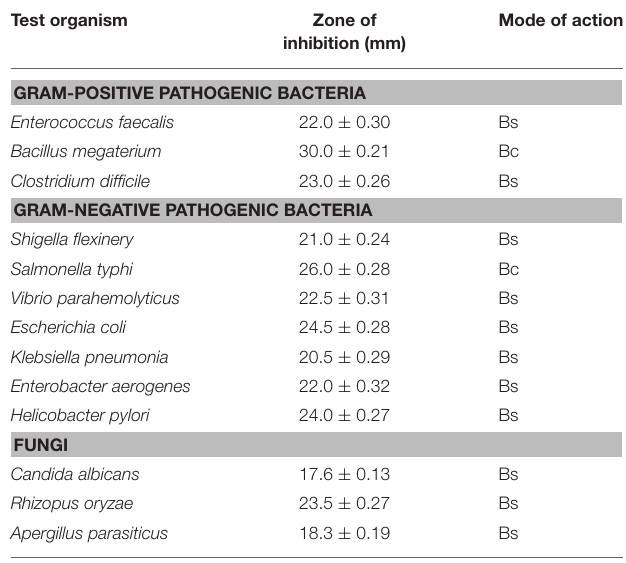
TABLE 4 | Antimicrobial activity of S. boulardii against test pathogens, inhibition zone measured in mm (mean ±